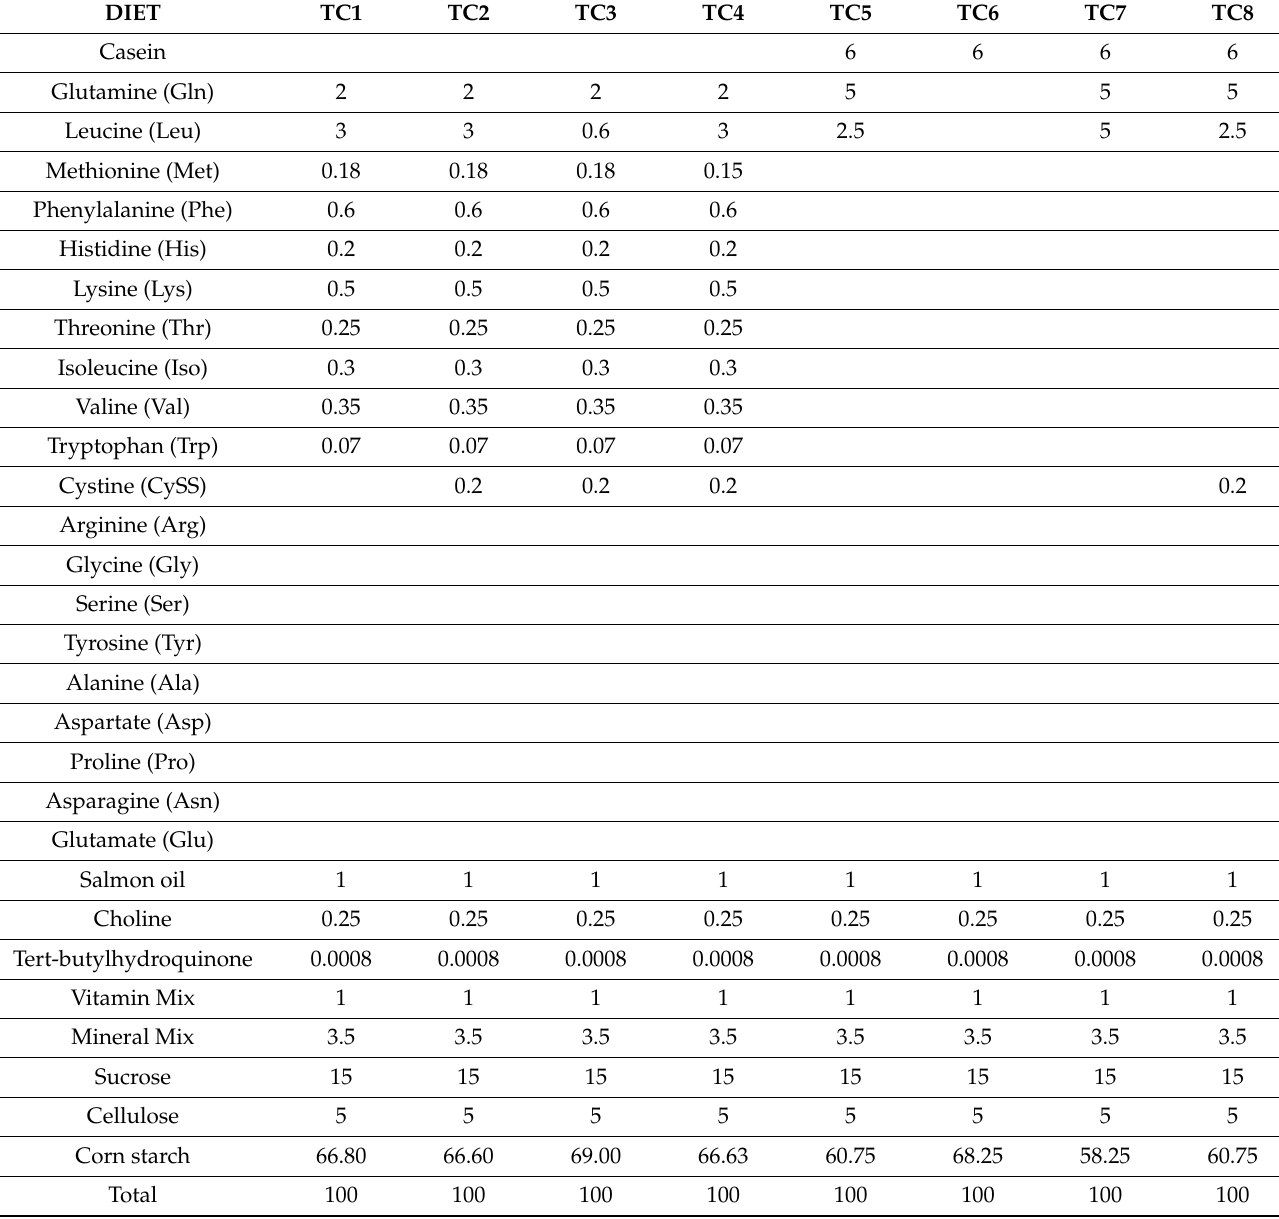
Table 2. Compositions of the 8 artificial diets used in this work (g/100 g dry